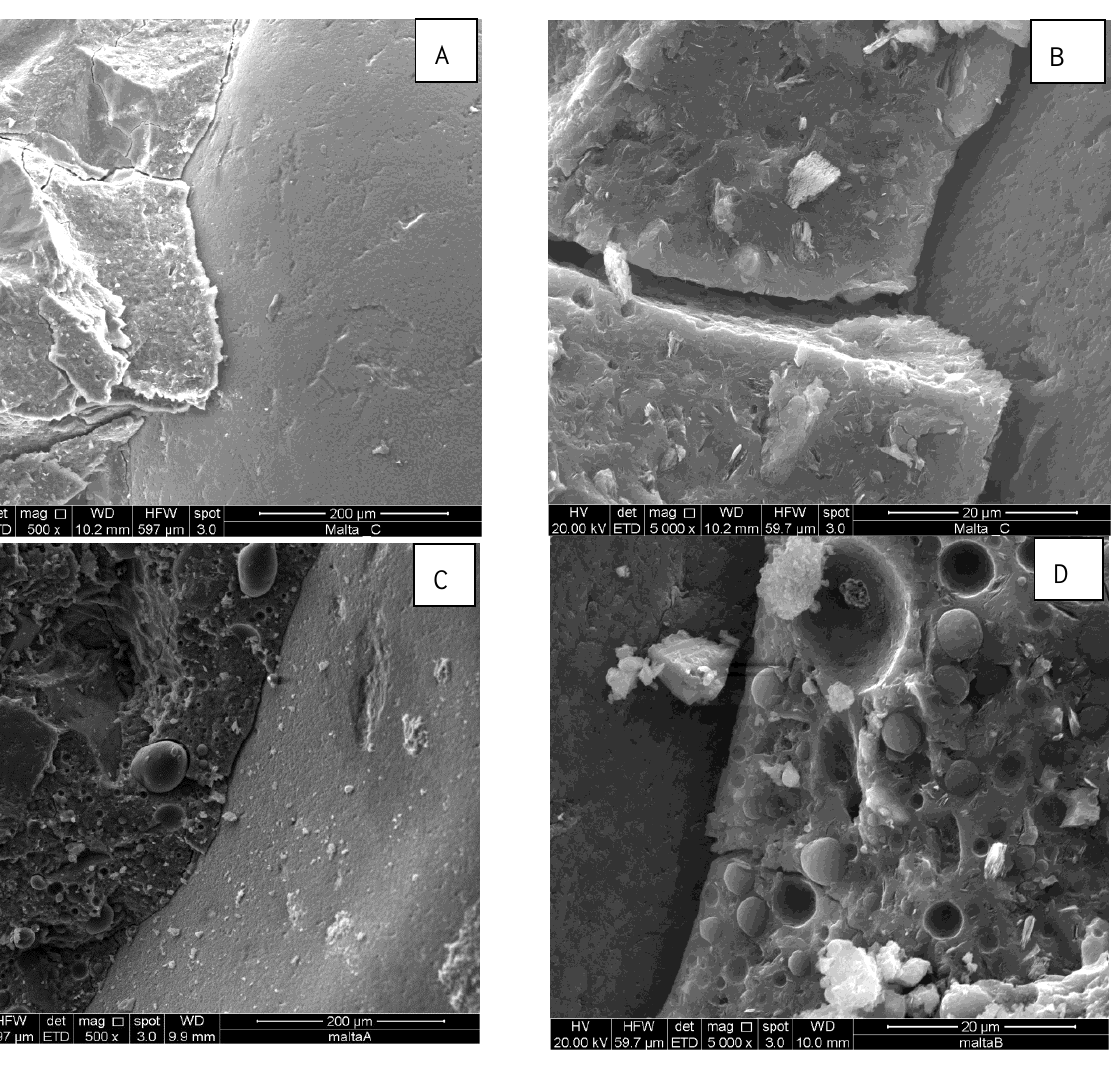
Figure 5. SEM micrographs of ( A , B ) the G66; and ( C , D ) E66